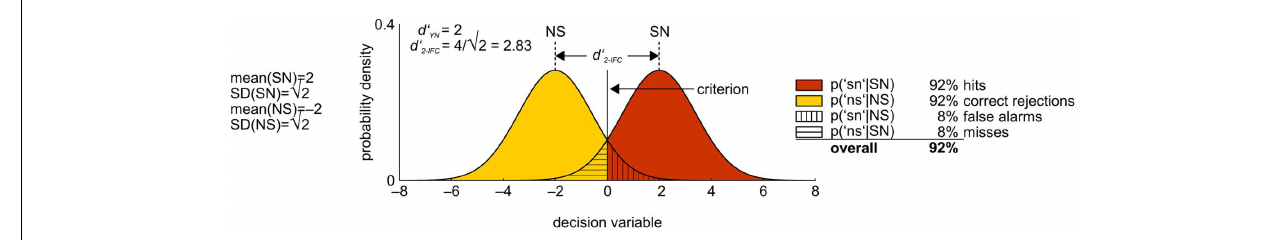
FIGURE 4 | Signal detection theoretical process model of performance in the 2-AFC task. See main text for